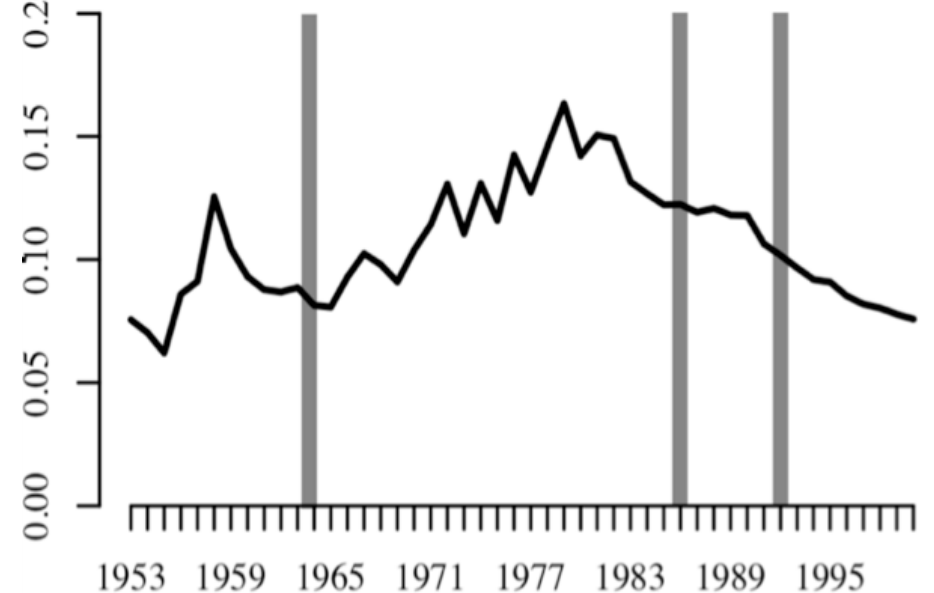
Figure 1: Modularity analysis of smoking hazards research. The dark line, corresponding to values on the Y axis, represents modularity scores scaled for logged network size. High levels of this measure correspond with contestation, whereas a declining scaled modularity refers to consensus formation. The X axis marks the year at the end of the observation window, and gray bars mark three important consensus reports: in 1964, the first U.S. Surgeon General report on the hazards of smoking; in 1986, reports by the IARC, NAS, and the U.S. Surgeon General; and in 1992, reports by the